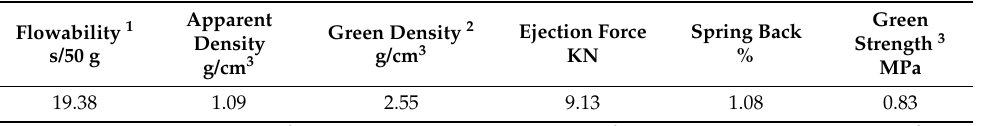
Table 5. The effect of Acrawax C admixed with Alumix 431D powder on the mixture’s properties and on its compaction